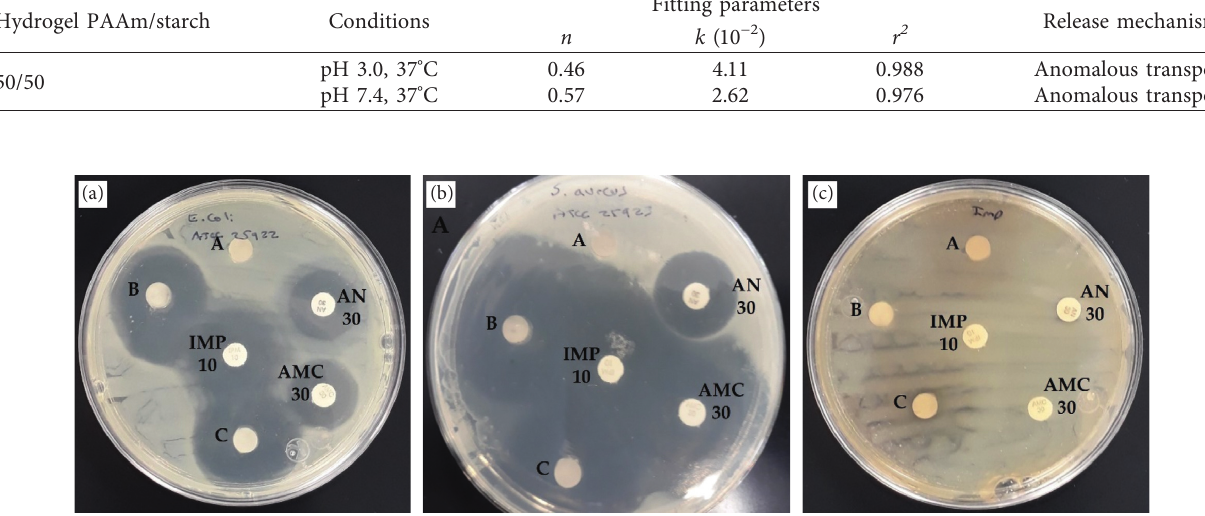
Figure 13: Growth inhibition effect of the PAAm/starch hydrogels against (a) E. coli ATCC 25922, (b) S. aureus ATCC 25923, and (c) carbapenemase producer, and amikacin-resistant, P. aeruginosa , after incubating at 37 ° C for 24h. A: hydrogel without drug (negative control); B: hydrogel loaded with 600 μ g amoxicillin; C: loaded with 1200 μ g amoxicillin; AN: amikacin (30 μ g); AMC: amoxicillin/clavulanic acid (20/10 μ g); IMP: imipenem (10 μ g). Table 3: Average of inhibition diameters zone from amoxicillin-loaded hydrogels and commercial discs. Strain